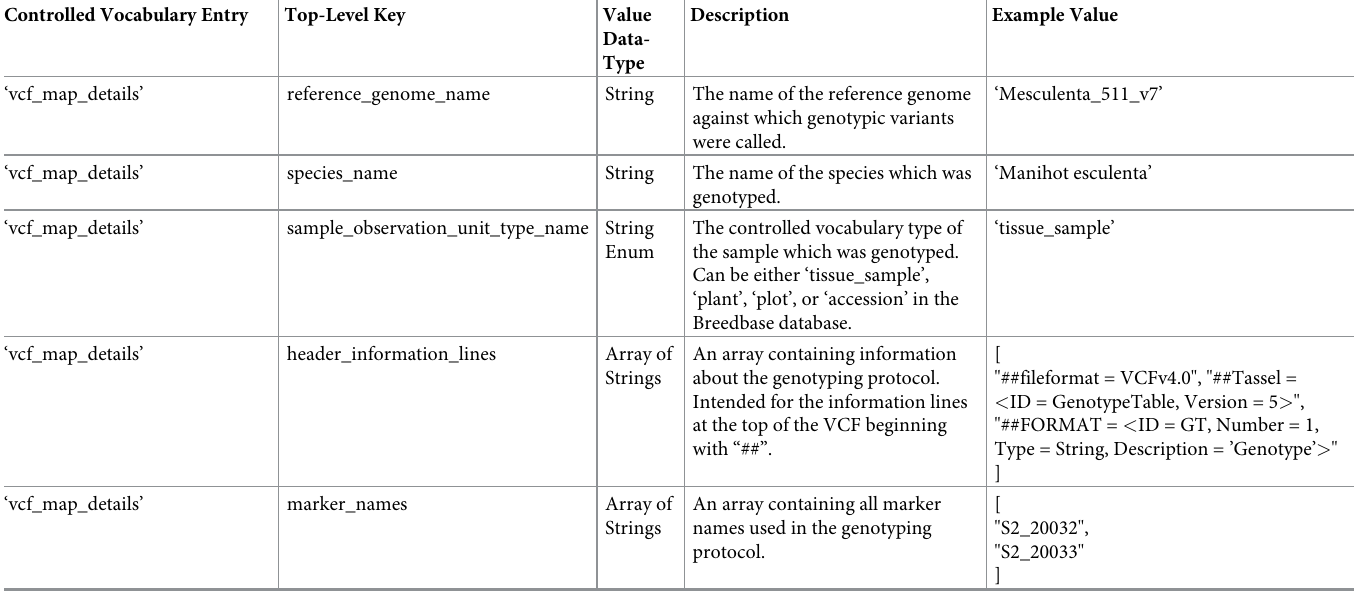
Table 1. Descriptions of the JSON objects stored in the nd_protocolprop